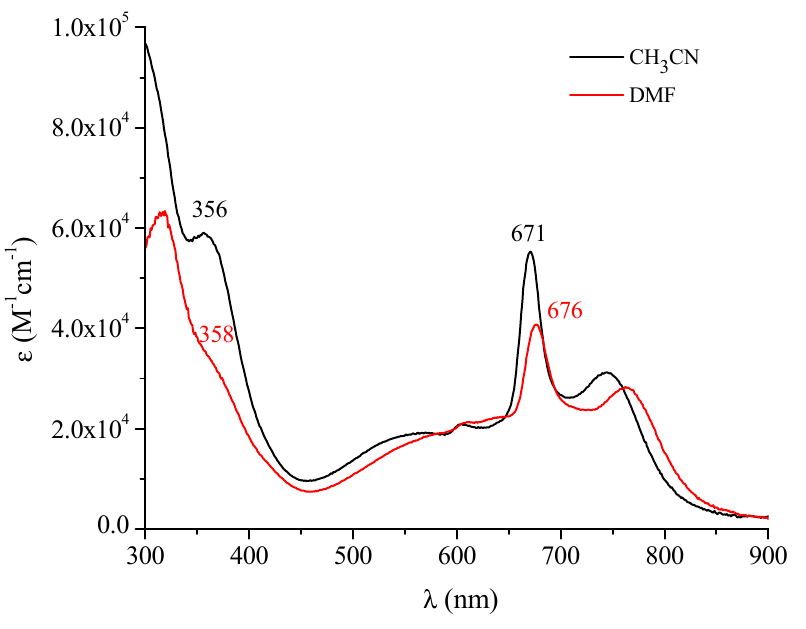
Figure 8. UV-visible spectra in the range 300–900 nm of the complex [(2-Mepy) 8 TPyzPzIn(OAc)] (I) 8 · H 2 O in DMF and CH 3 CN.